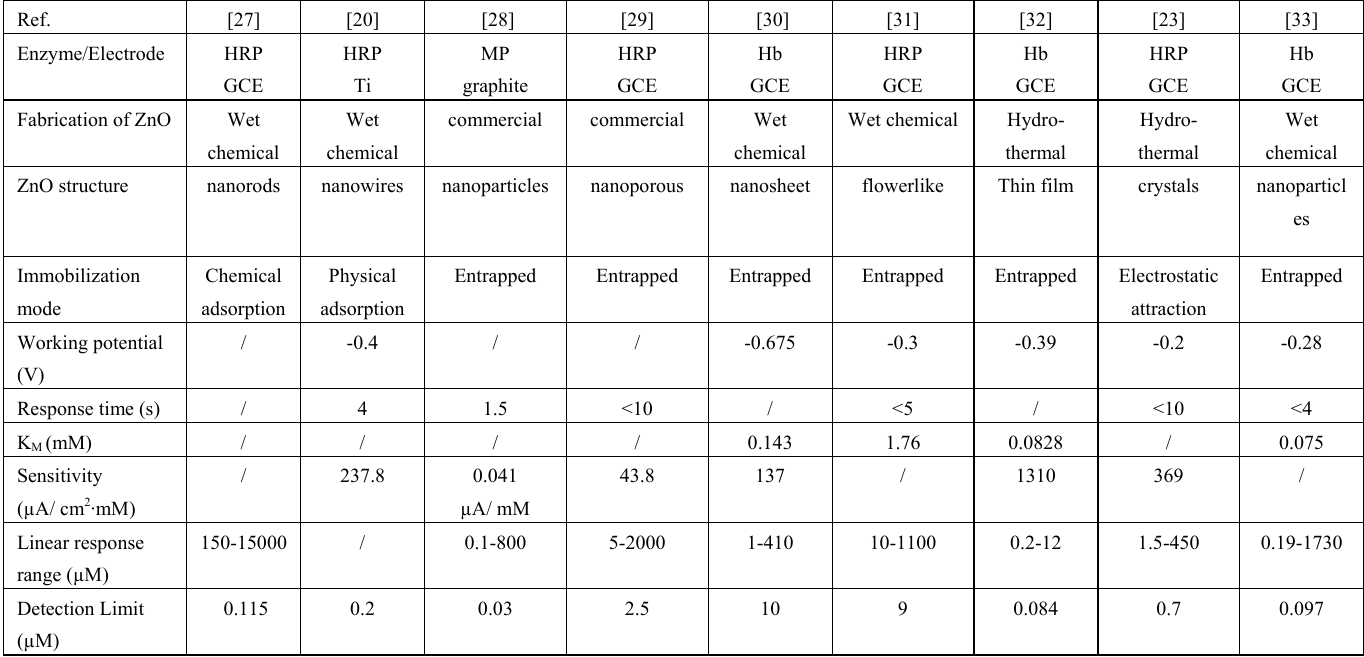
Table 2. ZnO-based electrochemical biosensors for hydrogen peroxide detection (HRP: horseradish peroxidase; Hb: hemoglobin; MP: microperoxidase; “/” in the table means the corresponding content is not